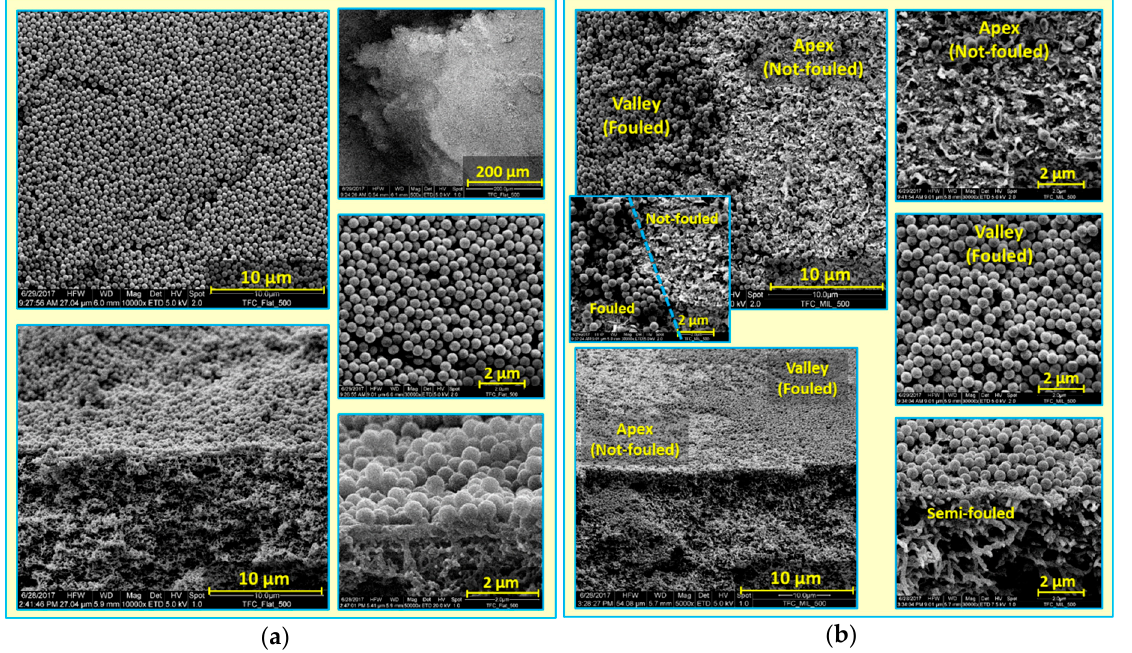
Figure 3. SEM micrographs at different magnifications for colloidal silica fouling of flat ( a ) and micro-patterned ( b ) pristine PA TFC membranes using silica microparticles (500 nm) in unstirred dead-end filtration conditions.